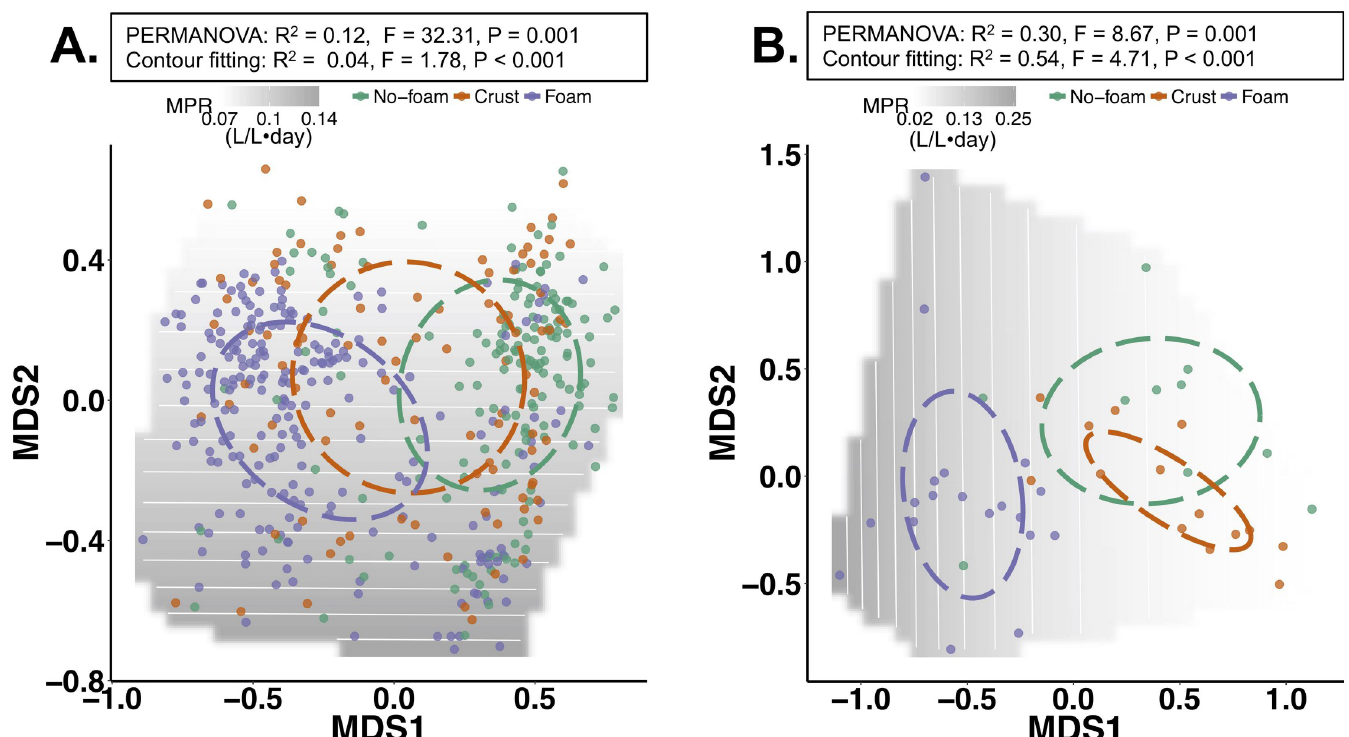
Fig 3. Non-metric multidimensional scaling (NMDS) analysis of bacterial communities (panel A) and methanogen communities (panel B) by the Bray-Curtis distances calculated using the relative abundance of microbial operational taxonomic units (OTU). The ellipses represent 95% confidence level around the centroids of manure samples with different surface textures. The microbial community variations among manure samples with different surface textures were assessed using Permutational Multivariate Analysis of Variance Using Distance Matrices (PERMANOVA). The methane production rates (MPR) were modeled to overlay the observed community differences (Contour fitting). The grey background shows the fitted MPR based on the measured MPR, with darker grey represents higher MPR.